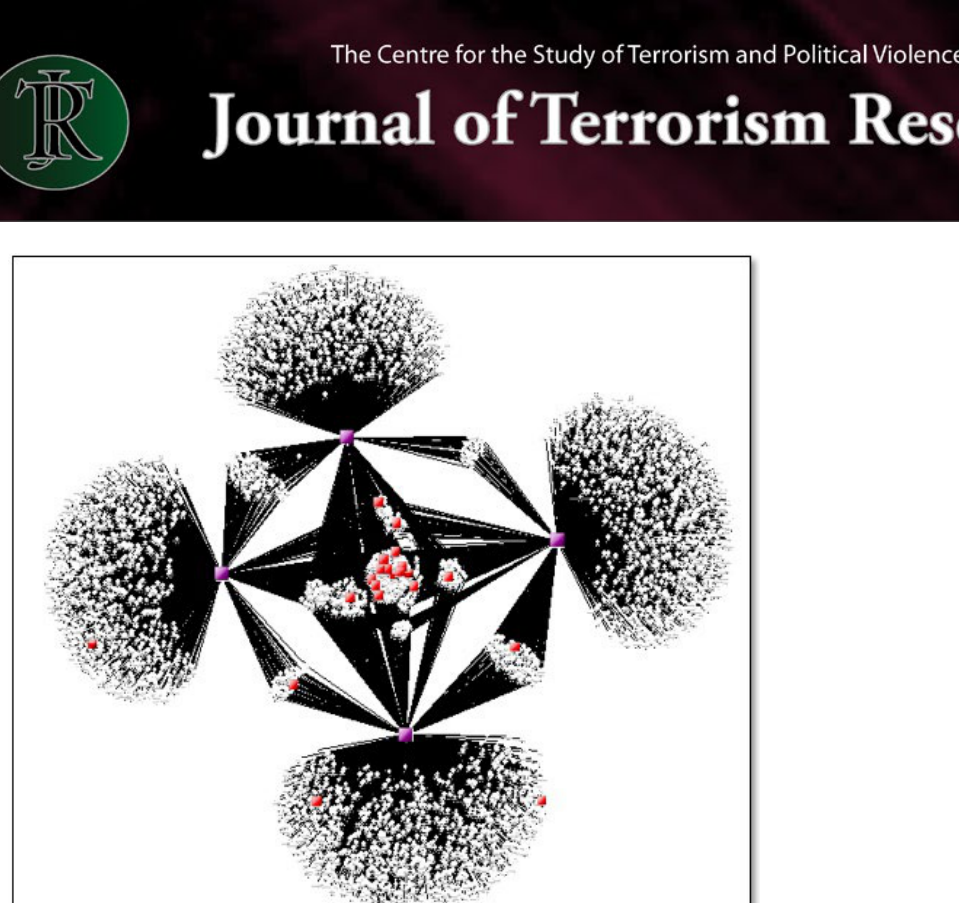
Figure 8: Social Network Graph, showing nicks active in the Vox.VoxAnon channel on four separate dates 1,7,14,21 October (dates represented by pink squares). White dots represent nicks with no privileges; red dots represent nicks with